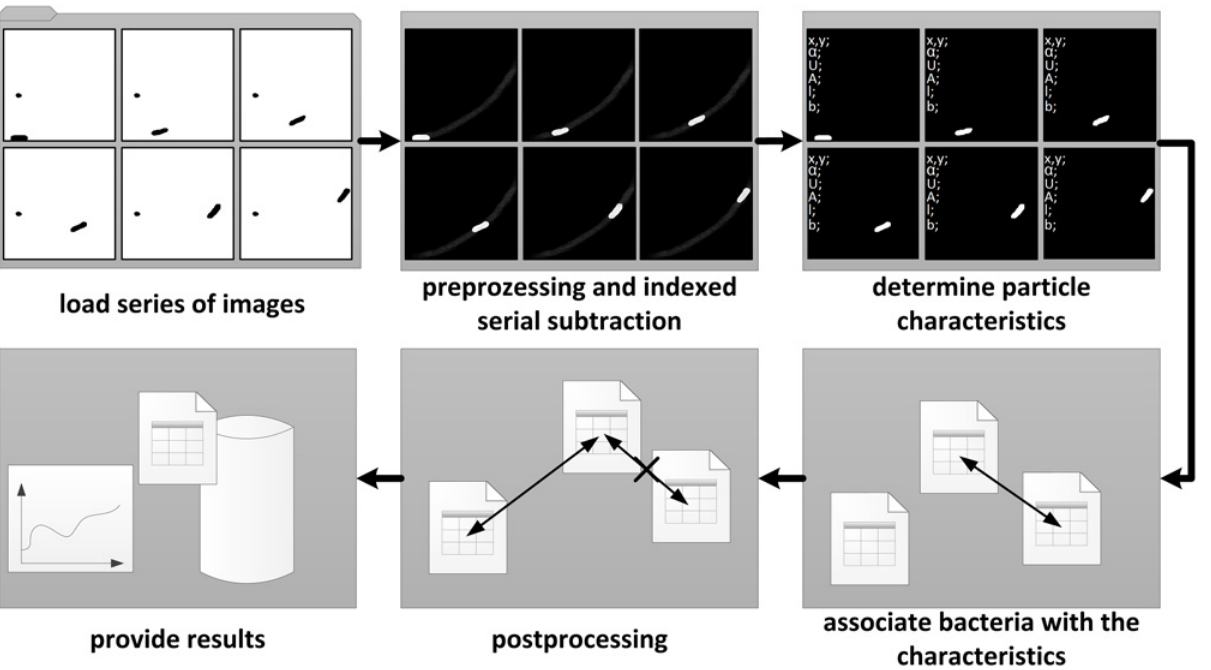
Fig 4. Simplified software structure of the image analysis. First, the series of images (30 frames at 30 fps represents 1 s) are loaded, before the indexed serial subtraction and the image processing starts. Now particle characteristics (center of mass x, center of mass y, perimeter, area, orientation, length, width) are determined. In the next step the bacteria are associated with the characteristics. After post-processing the results are